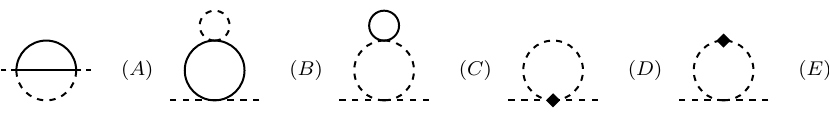
Figure 5 . Resummation in the unbroken phase computation with Z 2 symmetry. Solid (dashed) lines denote scalar propagators with hard (soft) momenta. These IR-sensitive non-analytic mixed soft/hard contributions are compensated by resummation interaction diagrams (diamond). Alter- natively, massless propagators in two-loop diagrams simplify the computation and retain the same result for the hard mode contribution relevant to